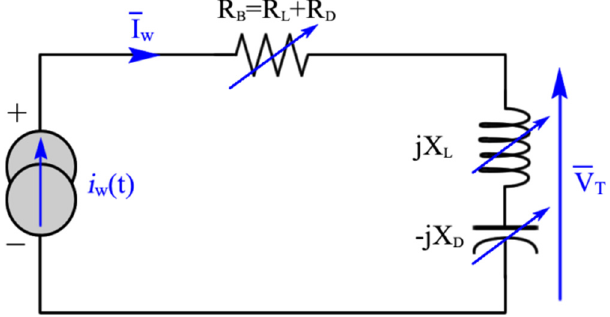
Figure 14. The torque produced by the blade reactive impedance.